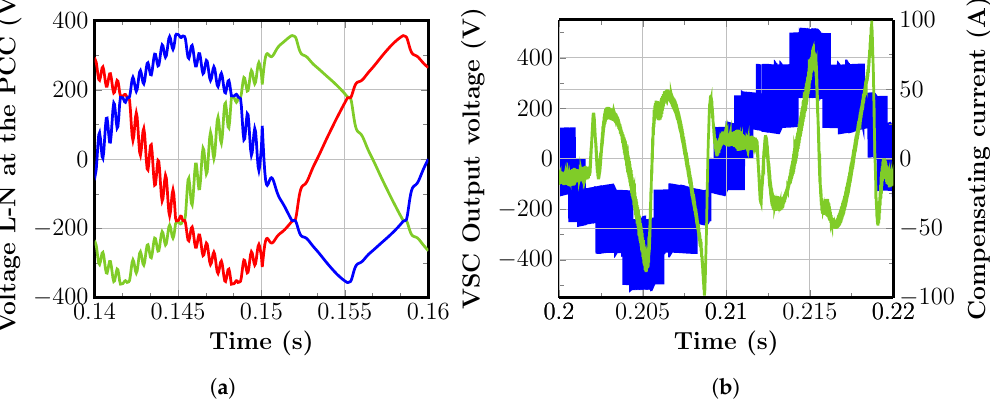
Figure 13. ( a ) V PCC behavior in presence of the 3L-ASYM-based VSAPF. ( b ) 3L-ASYM-based VSAPF compensating current I C for the phase A (green) and converter output voltage v o-N for the same